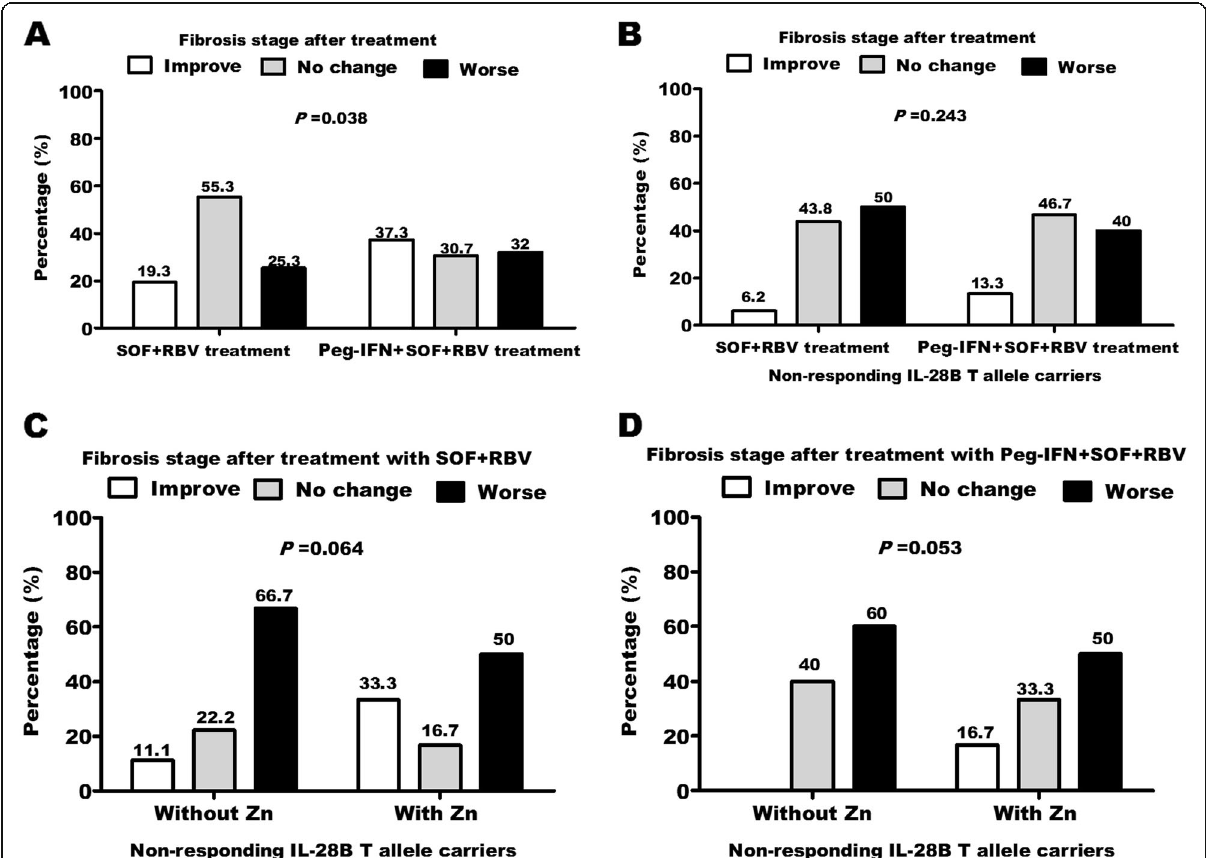
Fig. 3 A comparison of dual vs. triple antiviral therapy. A Fibrosis improvement was more noticeable ( P = 0.038) in patients treated with SOF/RBV than patients treated with SOF/RBV + Peg-INF. Regarding only non-responders of T allele carriers, B triple treatment (SOF/RBV + Peg-INF) decrease patient ’ s liver stiffness more efficiently than dual treatment and also zinc administration decrease patient ’ s liver stiffness in both C SOF/ RBV and D SOF/RBV + Peg-INF